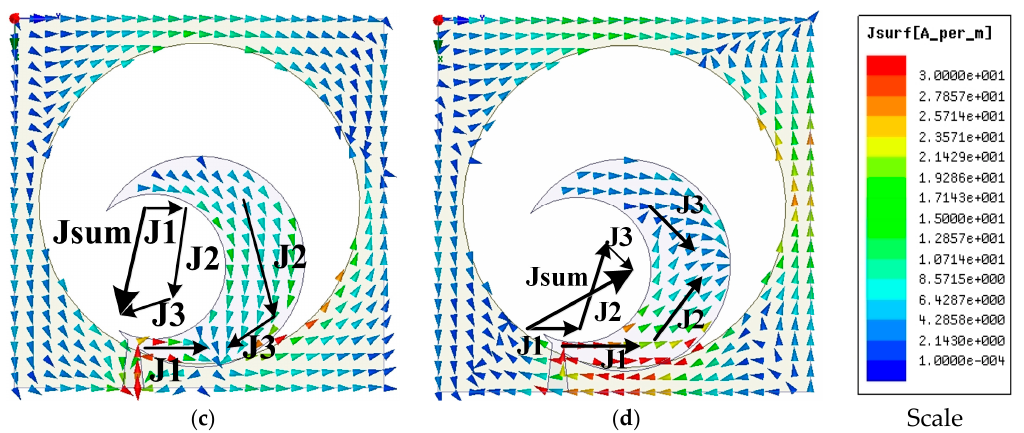
Figure 4. The simulated surface current distributions at 2.60 GHz ( a ) t = 0 ( b ) t = T/4 ( c ) t = T/2 ( d ) t = 3T/4.